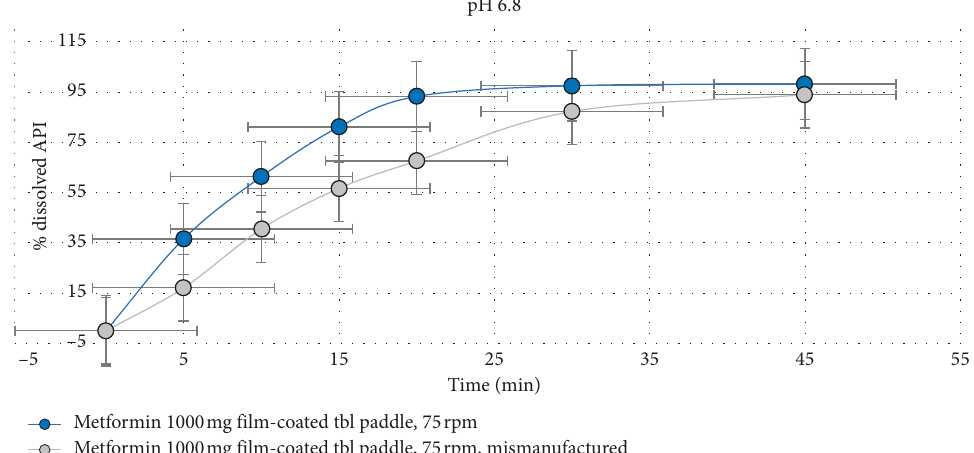
Figure 3: Dissolution profiles of original formulation and formulation with a deliberate change in the composition of excipients (mismanufactured).